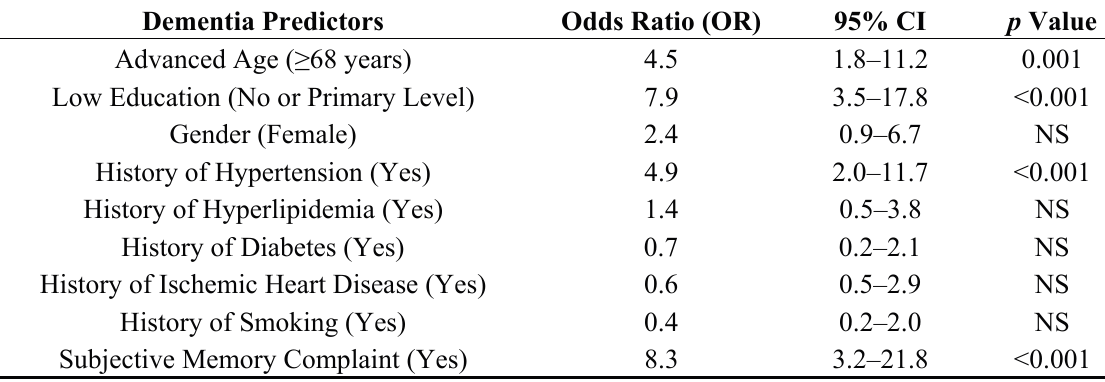
Table 4. Logistic regression analyses for dementia risk factors in predicting possible dementia